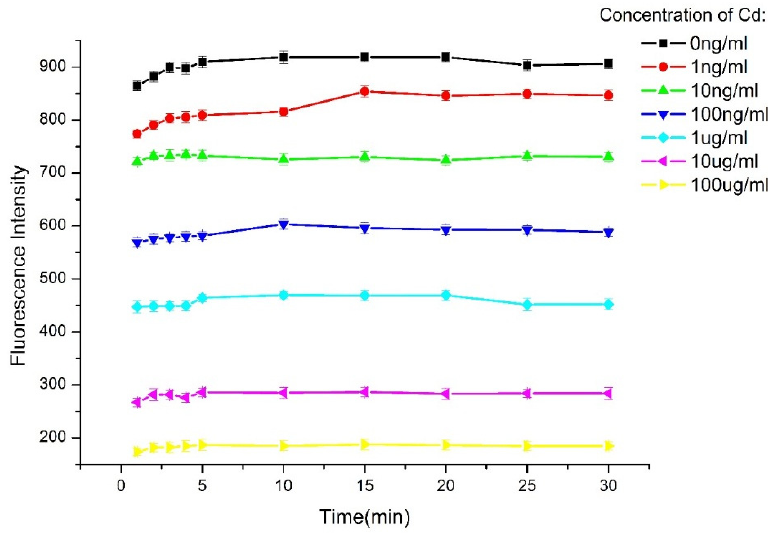
Figure 1. Optimization of the incubation time for the interaction between PicoGreen and double stranded deoxyribonucleic acid at the temperature of 25 °C.